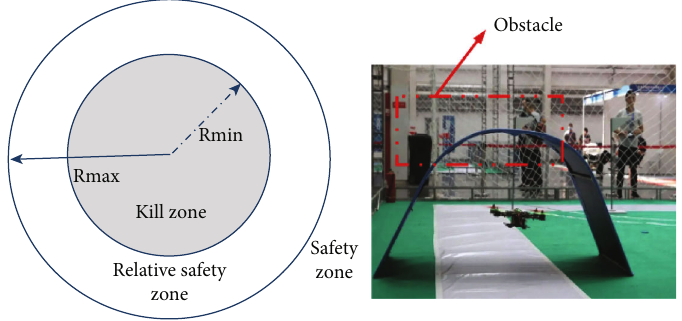
Figure 2: Obstacle signal threat